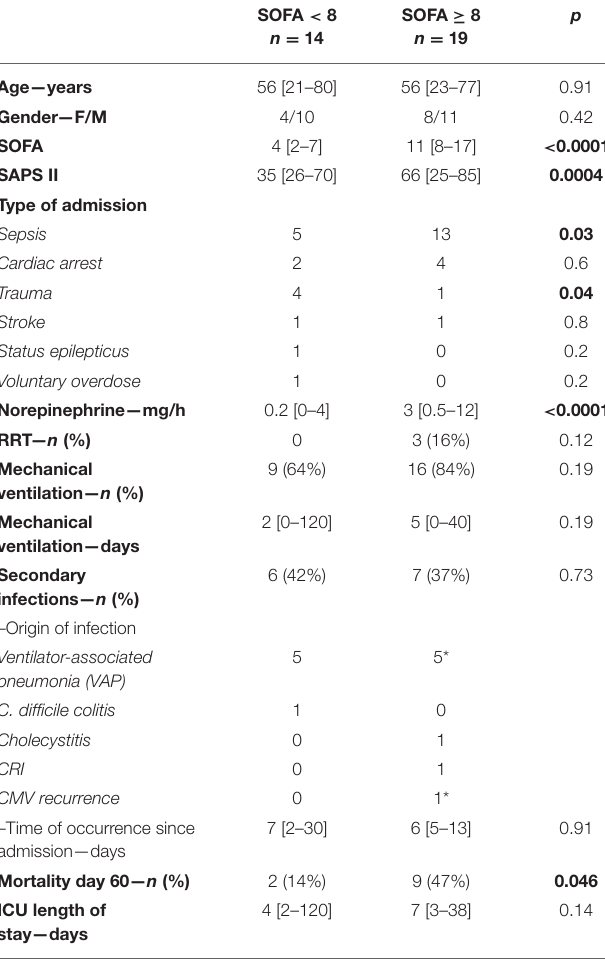
Eighteen patients with septic shock were included ( ICU Sepsis Group ). The sources of infection and bacterial strains are